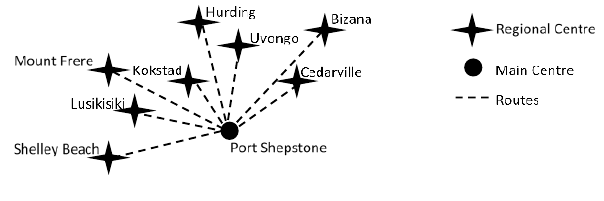
Figure 1: Regional routes converge into a main centre (This figure is only a representation and is therefore not drawn to scale).